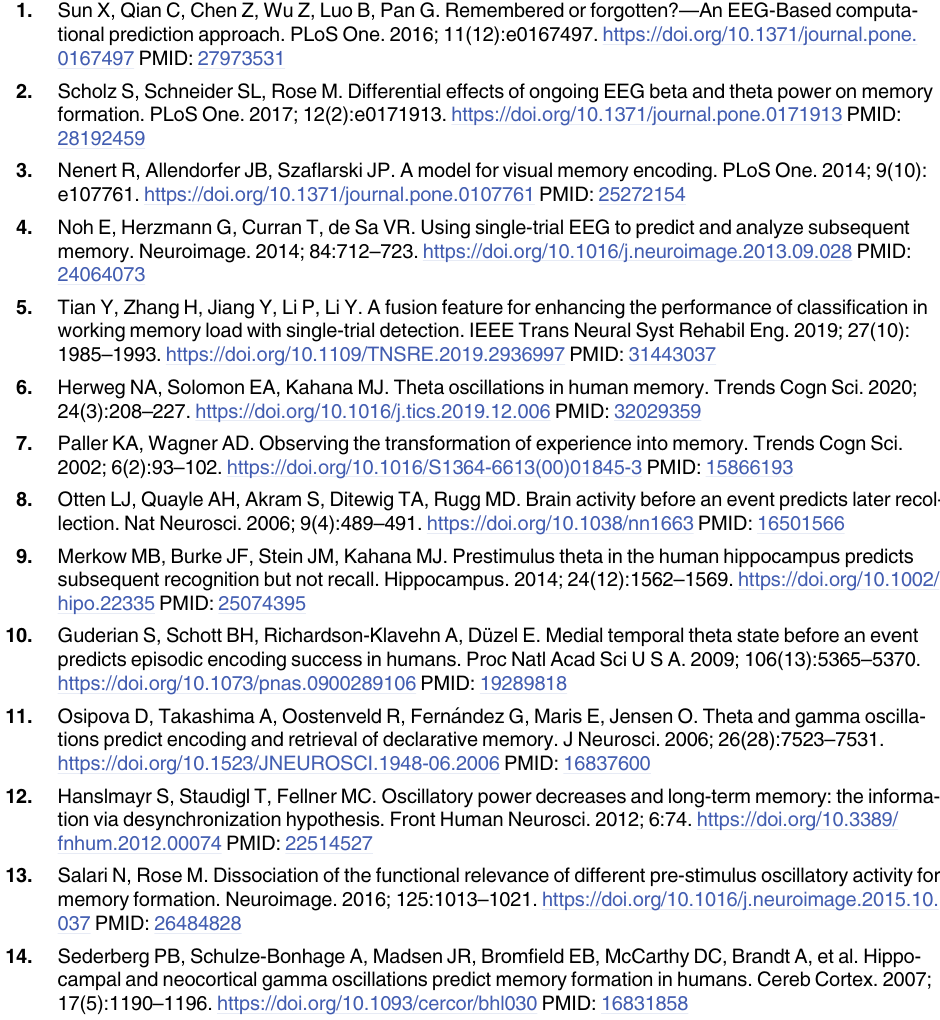
S1 Table. R 2 and F-values for pre-stimulus and on-going stimulus segments. Hierarchical linear regression was computed to compared the effects of using surface potentials alone or including spatial features trough source